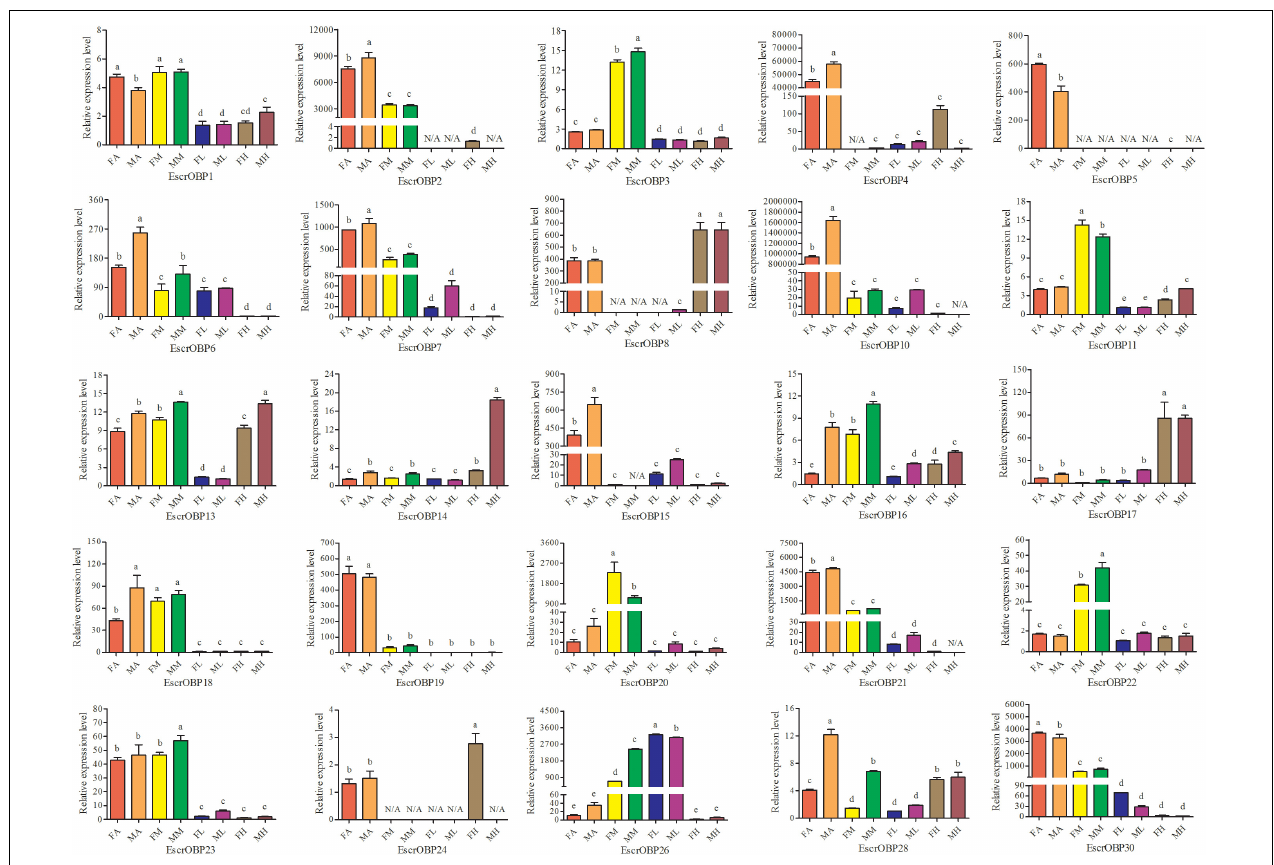
FIGURE 6 | Relative expression levels of E. scrobiculatus OBPs in different tissues of female and male adults by RT-qPCR. FA, female antennae; MA, male antennae; FM, female rostrums; MM, male rostrums; FL, female legs; ML, male legs; FH, female head (with antennae and rostrum cut off); MH, male head (with antennae and rostrum cut off). The bar represents standard error and the different small letters (a–e) above each bar indicate significant differences ( P < 0.05). N/A indicates that the transcript level is too low to